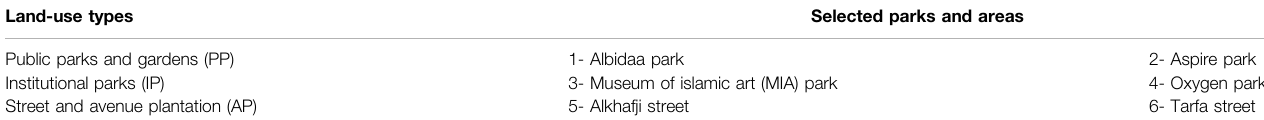
TABLE 1 | The land-use types and the selected parks and areas. Land-use types Selected parks and areas Public parks and gardens (PP)